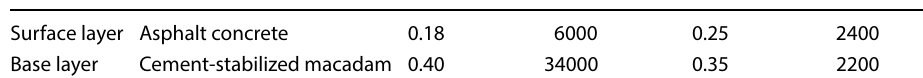
Table 5 Properties of the pavement structure